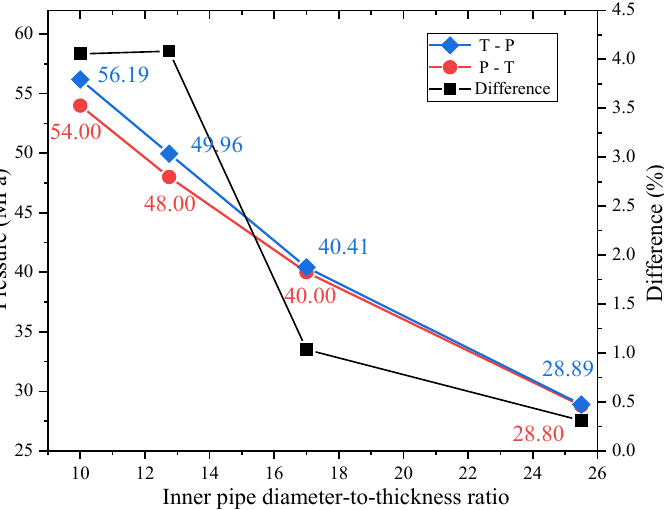
Figure 12. Collapse pressure of sandwich pipe with different inner pipe diameter-to-thickness ratios.